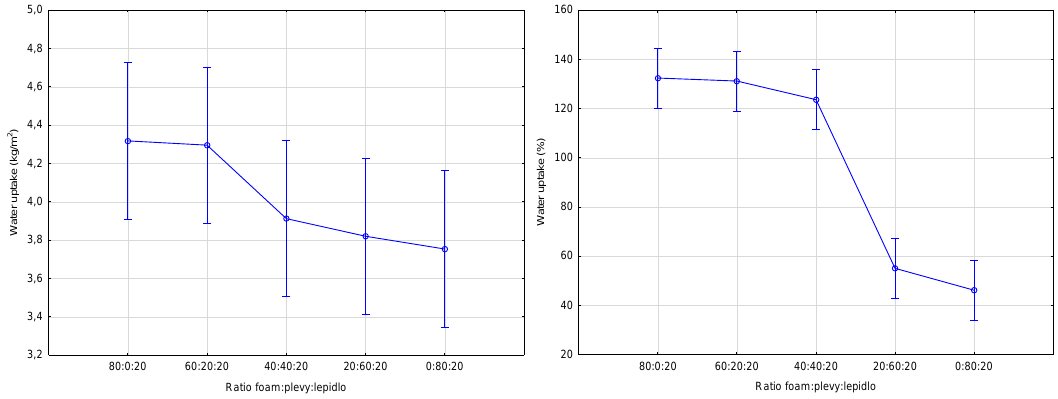
Figure 6. Impact of the composition of the panel on short-term absorption. Table 8. p-values of Tukey post-hoc test: statistical significance of the differences in the graph in Figure 6a. Ratio